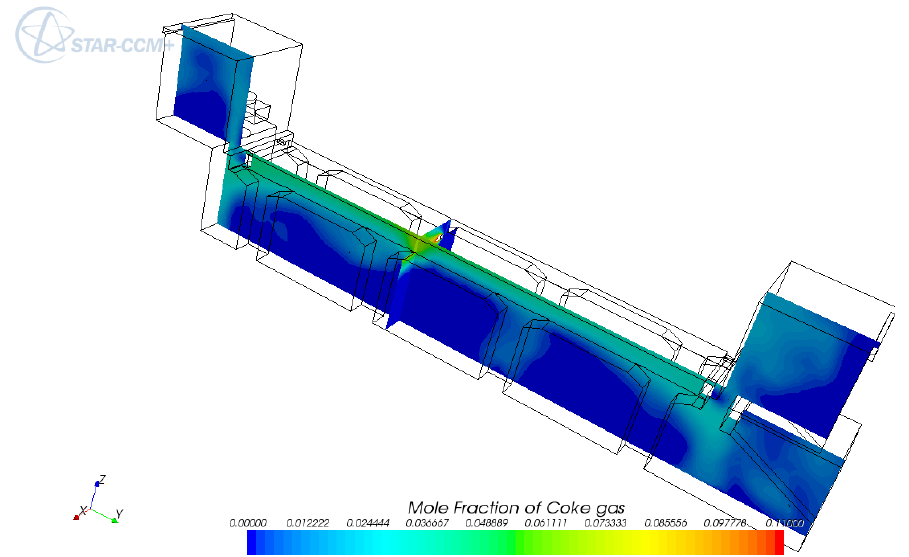
Figure 5. CFD model: mole fraction of coke gas at 600 s from the beginning of the release in coke battery A under the designed ventilation